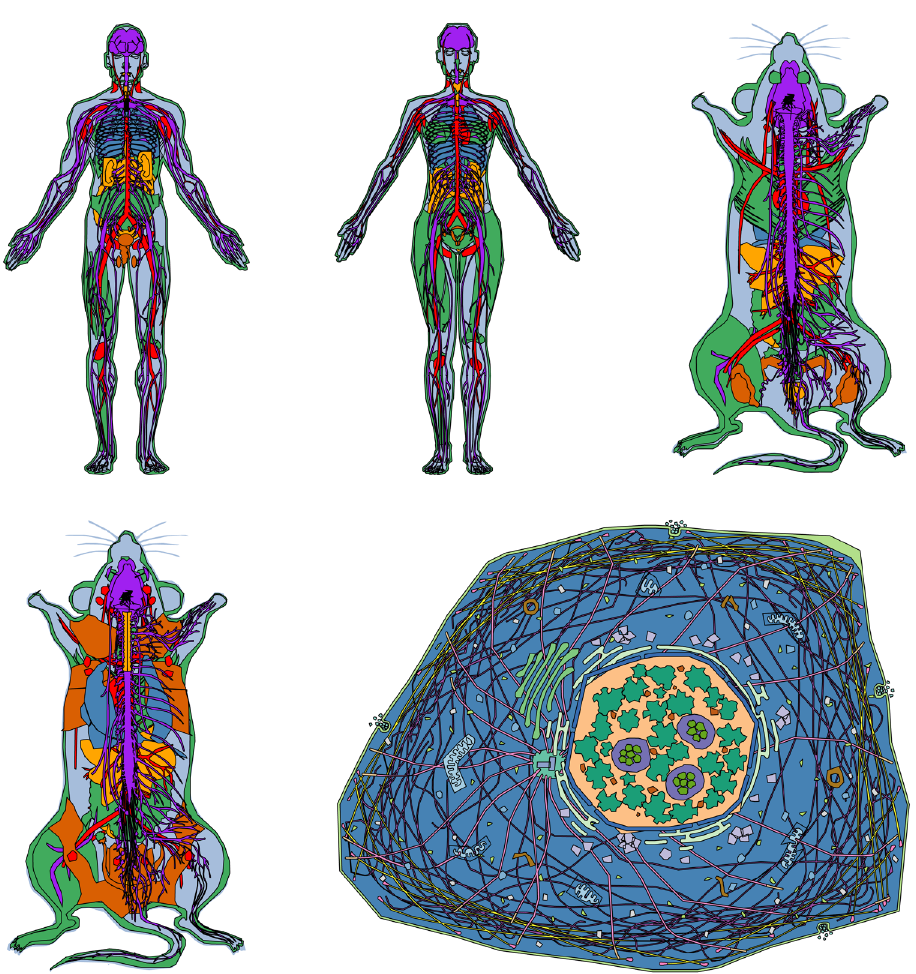
Figure 3. Displaying all tissues available for human and mouse, male and female. The colours are specified in the provided key data frames. To compare anatograms, e.g. draw one specific anatogram side by side and compare values, a long table has to be created with the type column changed to the variables to compare. The following code recreates (Figure 1c). normal <- data.frame(organ = c("heart", "leukocyte", "nerve", "brain",